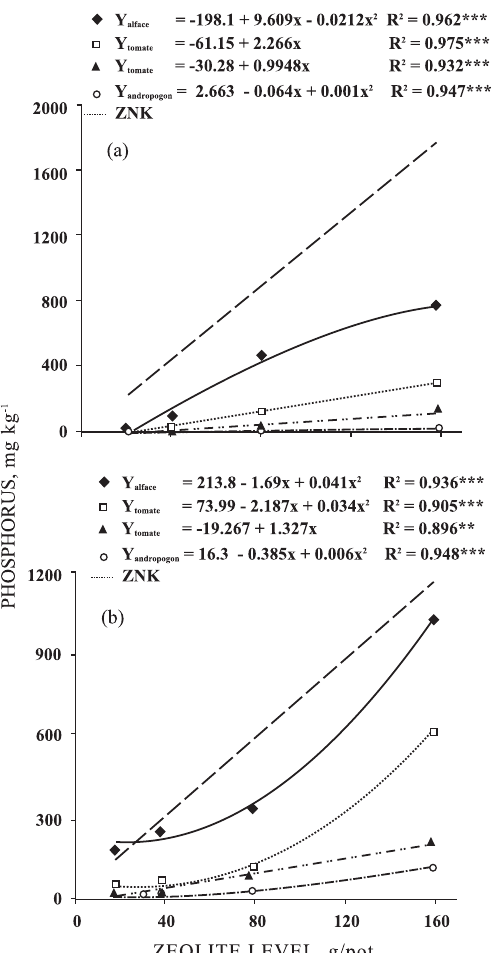
Figure 4. Phosphorus levels in the treatments zeolite + K HPO (ZPK – a) and zeolite + H 2 4 (ZP - b) in the saturation paste extract of the substrate, after successive crops of lettuce, tomato, rice, and andropogon grass (two cuts). The dotted line indicates the content at the beginning of the